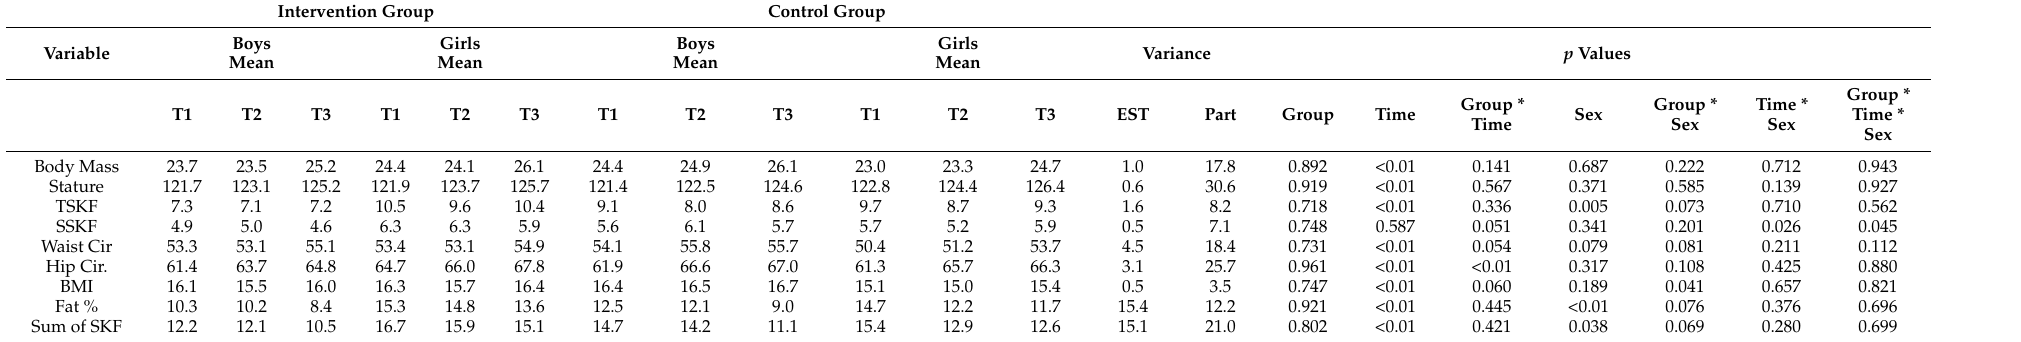
Table 2. Possible influences of co-variants on the anthropometric variables of the participants. Intervention Group Control Group